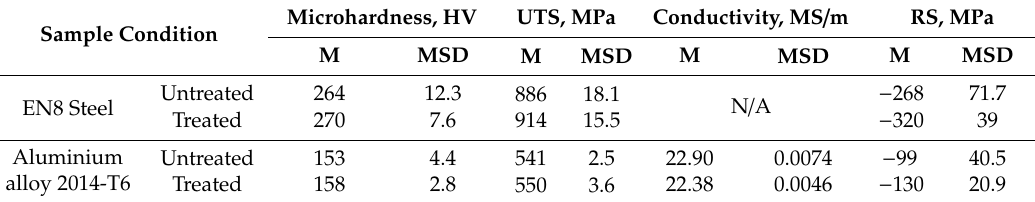
Table 3. Mean (M) and mean-square deviation (MSD) results of microhardness, tensile strength, conductivity and RS.